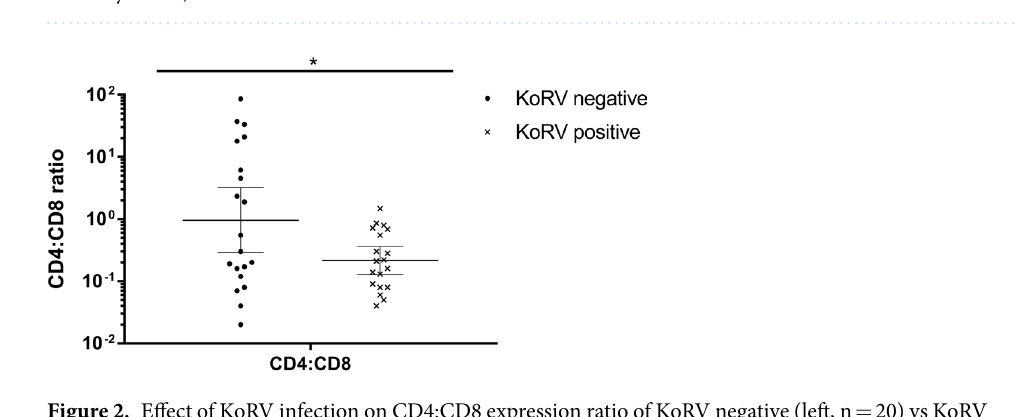
Figure 1. The effect of Koala retrovirus (KoRV) status on cytokine expression. Geometric mean and 95%CI of the geometric mean for relative expression of cytokine levels, compared to reference genes calculated using the Δ Cq method 87 . IFN γ and IL17A were significantly decreased in KoRV positive koalas ( * p < 0 . 05 Mann- Whitney U test).